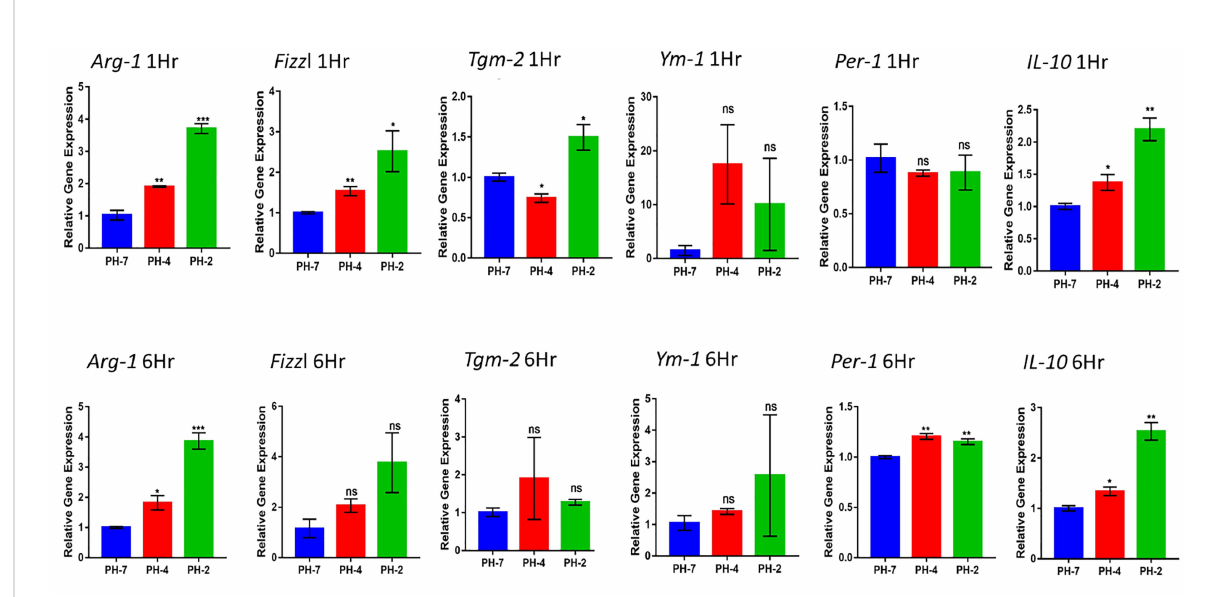
FIGURE 3 Macrophage relative expression of Arg1, Fizzl, Tgm2, Ym1, Per-1, and the M2-cytokine gene, IL-10 under the acid microenvironment. * means p< 0.05, ** means p< 0.01, *** means p < 0.005. ns means not signi fi